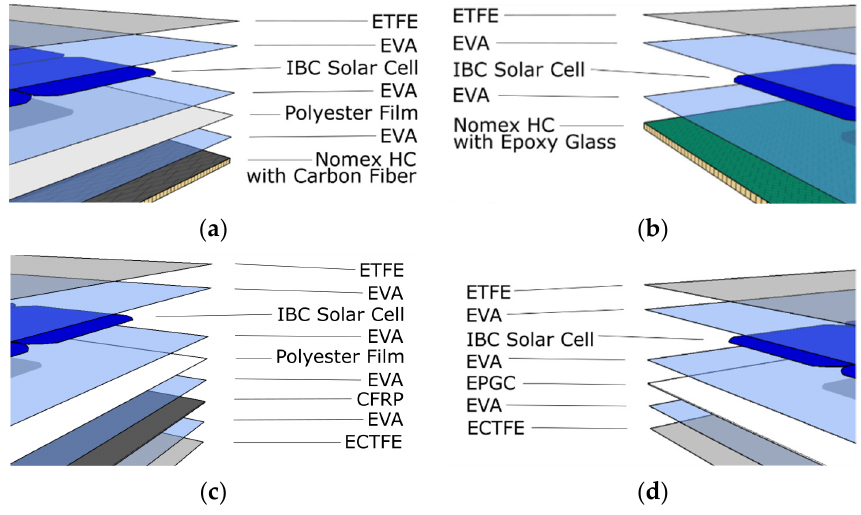
Figure 2. Prototypes layers in detail: ( a ) P1; ( b ) P2; ( c ) P3; ( d ) P4.